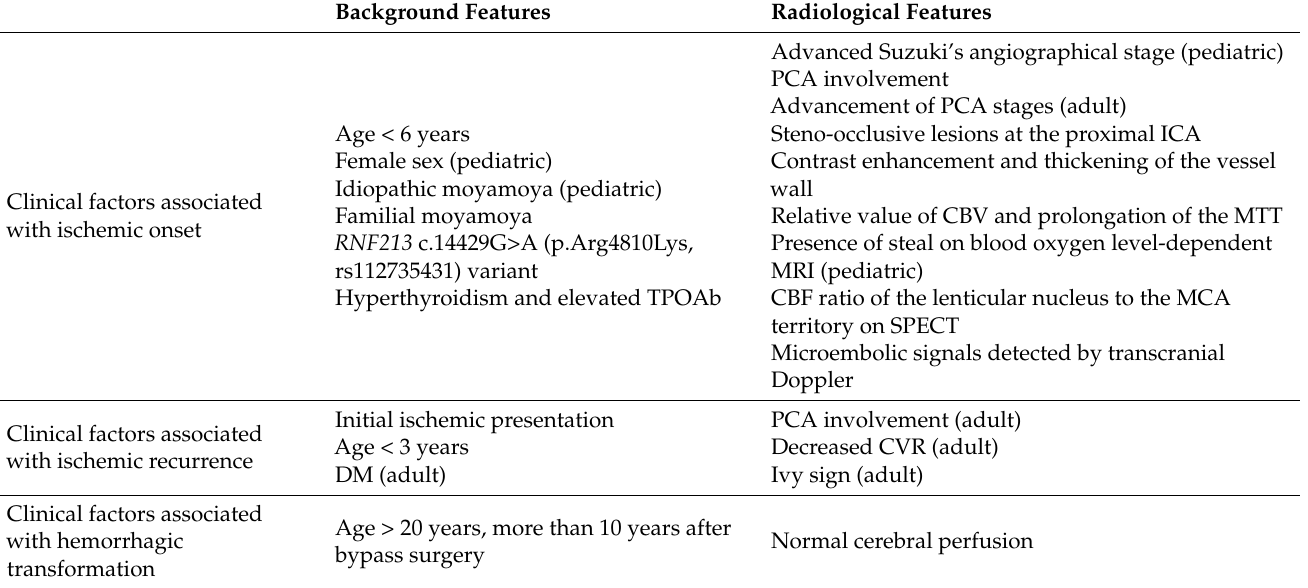
Table 7. Summary of clinical factors of clinical features associated with each onset pattern in moyamoya